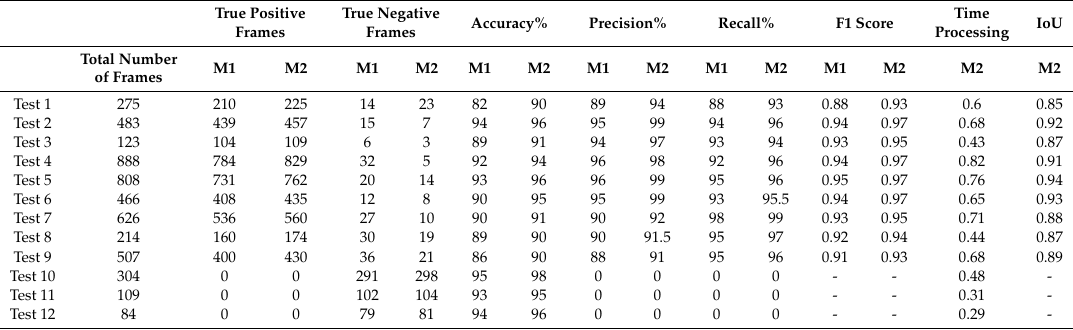
Table 3. Results of testing the proposed method on some videos containing smoke, fogs or clouds. (M1: method of Yuanbin [18]; M2: the proposed